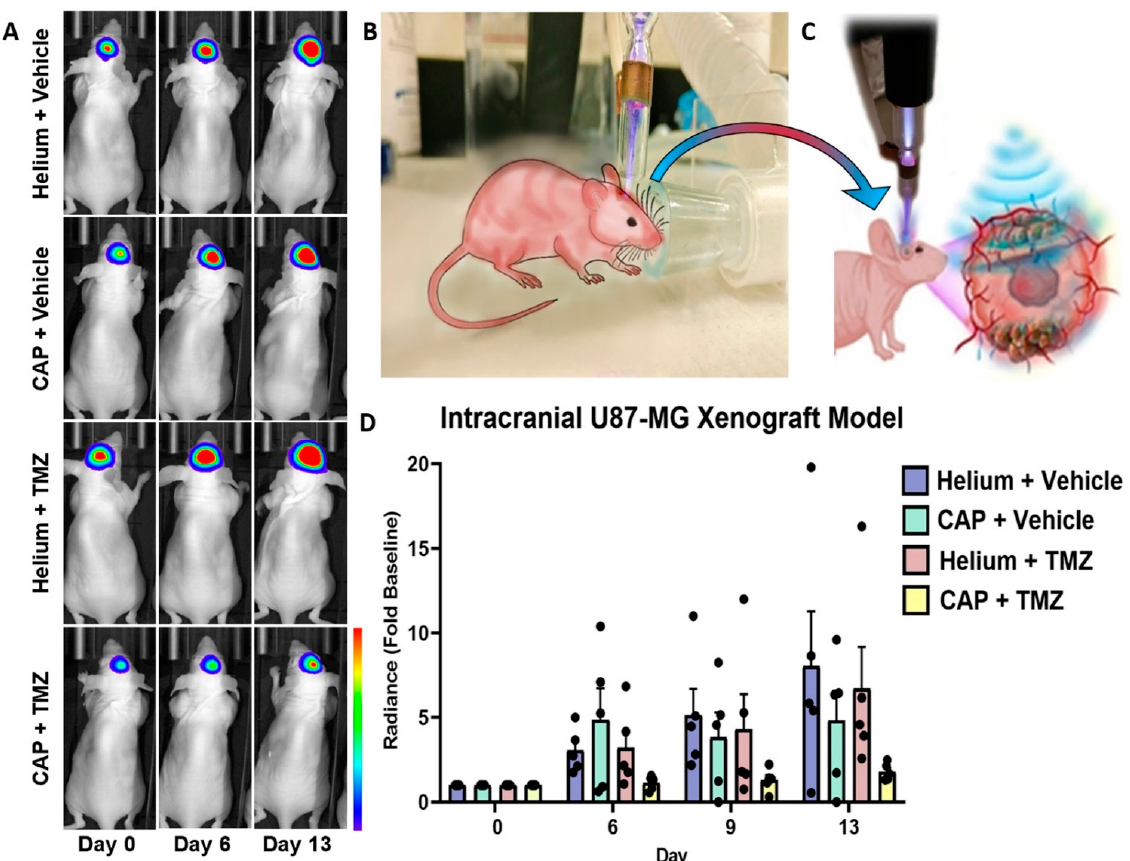
Figure 8. Schematic representation of in vivo CAP targeting plus TMZ treatment of intracranial GBM tumors in nude mice.